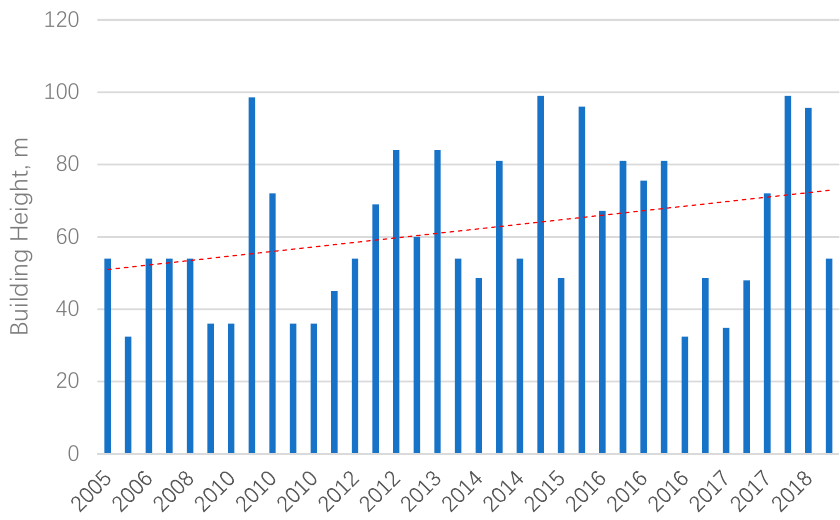
Figure 2. The height of the investigated high-rise buildings by year completed.